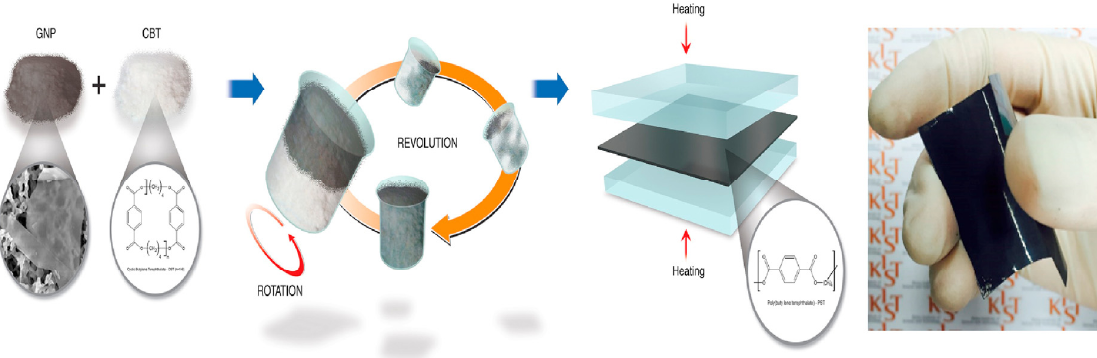
Figure 6. Schematic of solvent-free one-step synthesis based on powder mixing and in situ polymerization for composite film filled with highly disperse GNP fillers. Reproduced with permission from [48].